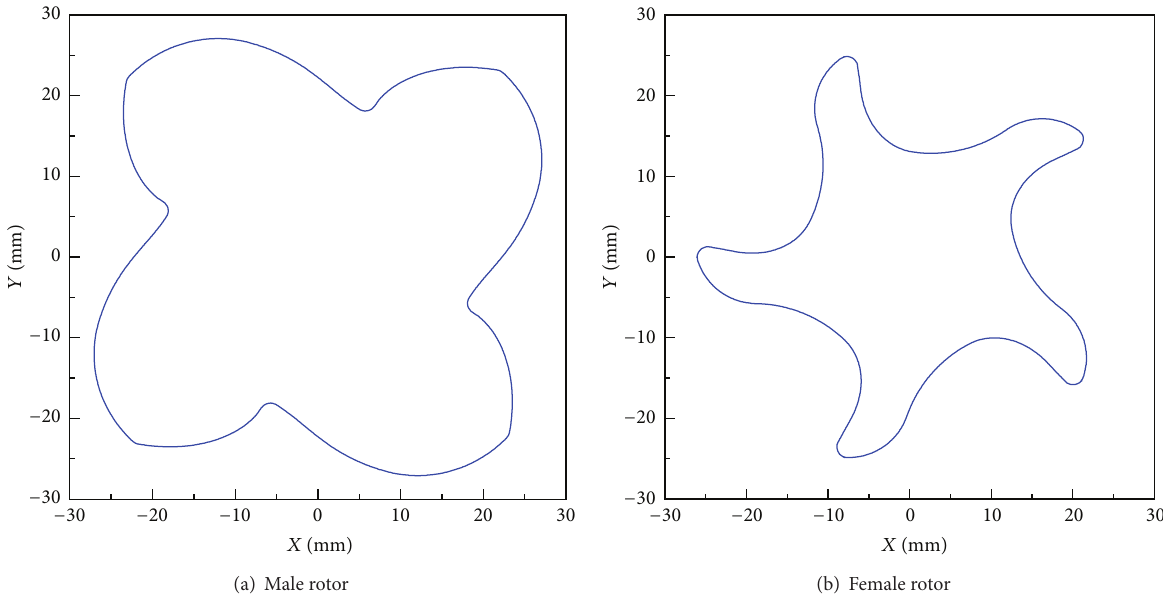
Figure 4: Cross-section contour of